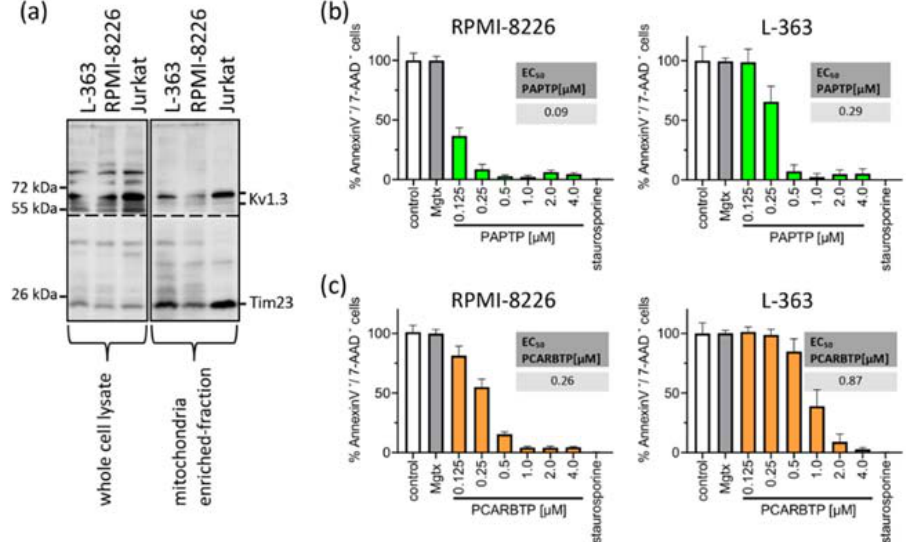
Figure 1. Mitochondrial Kv1.3 is expressed in the multiple myeloma cell lines L-363 and RPMI-8226. PAPTP and PCARBTP efficiently kill human multiple myeloma cells. ( a ) Whole cell lysates (left, 50 µ g protein/lane) were lysed in RIPA-Buffer, mitochondria from L-363, RPMI-8226 and Jurkat cells (right, 30 µ g protein/lane) were enriched as described; both were supplemented with 5 × reducing SDS sample buffer, boiled and separated on 8.5% SDS-polyacrylamide gels and blotted on nitrocellulose membranes. Membranes were divided and, after blocking, membranes were incubated 1 h with anti-Kv1.3 or anti-Tim23 primary antibodies, respectively. After extensively washing, blots were incubated with secondary antibodies for 1 h, washed and developed with the Roti–Lumin system. Multiple myeloma cell lines RPMI-8226 and L-363 were treated with increasing concentrations PAPTP ( b ) or PCARBTP ( c ), solvent control (0.1% DMSO), 2 µ M staurosporine as a positive control and 2 µ M margatoxin as a membrane-impermeable Kv1.3 blocker. After 24 h, cells were stained with Annexin V-APC/7AAD and examined for cell death by flow cytometry. Results are reported as percent- ages with respect to untreated samples ± SD, ( n = 3 independent experiments, each experiment in triplicate). Graph insert EC50: EC50 values of the indicated compounds in RPMI-8226 and L-363 were calculated by using GraphPad Prism version 9.3 for Windows (GraphPad Software, San Diego, CA,